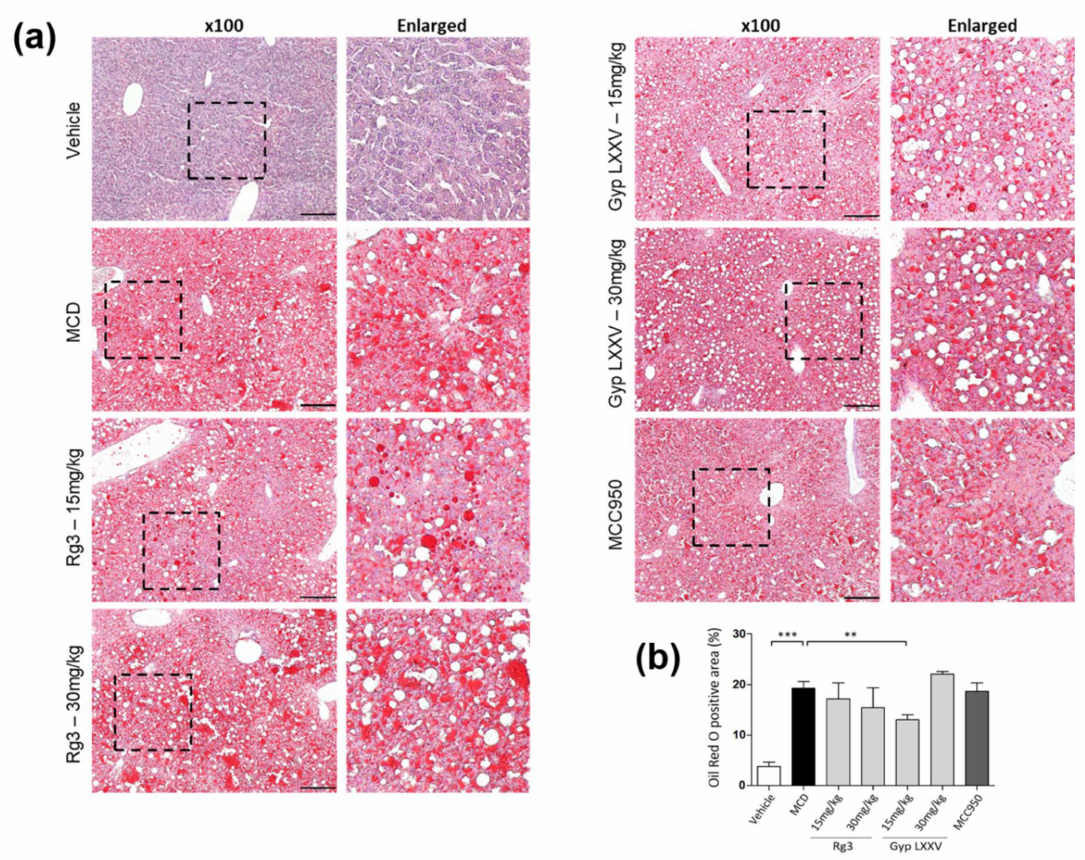
Figure 5. Oil red O staining of liver sections from the control and MCD-induced mice groups to validate the ameliorating e ff ect of Gyp LXXV against hepatic lipid accumulation. ( a ) 100x magnification, scale bar 200 µ m. Quantification of oil red O staining was performed using Fiji software ( b ). Error bars represent SEM. ** p < 0.01, *** p < 0.001 vs. MCD, two tailed unpaired